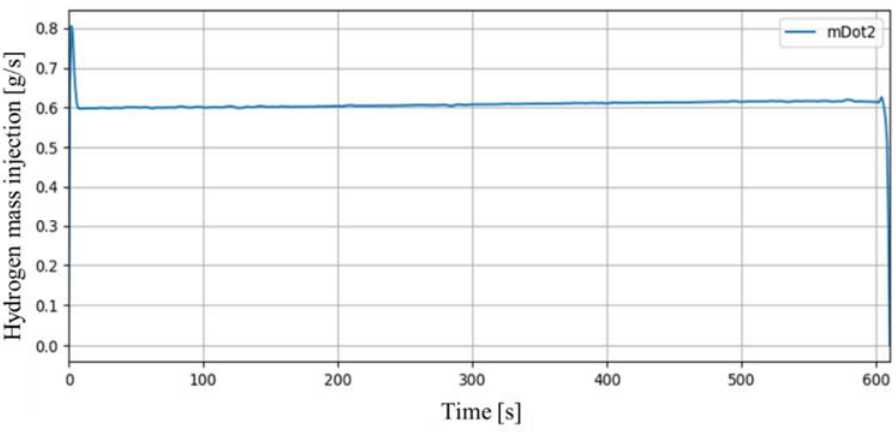
Figure 8. Mass flow rate of hydrogen injection in SP1 experiment.